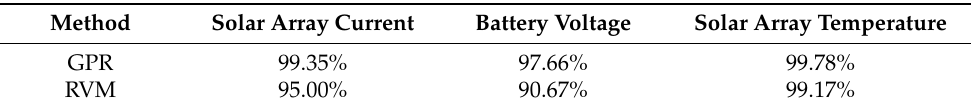
Table 3. The optimal CP for telemetry series based on SA.